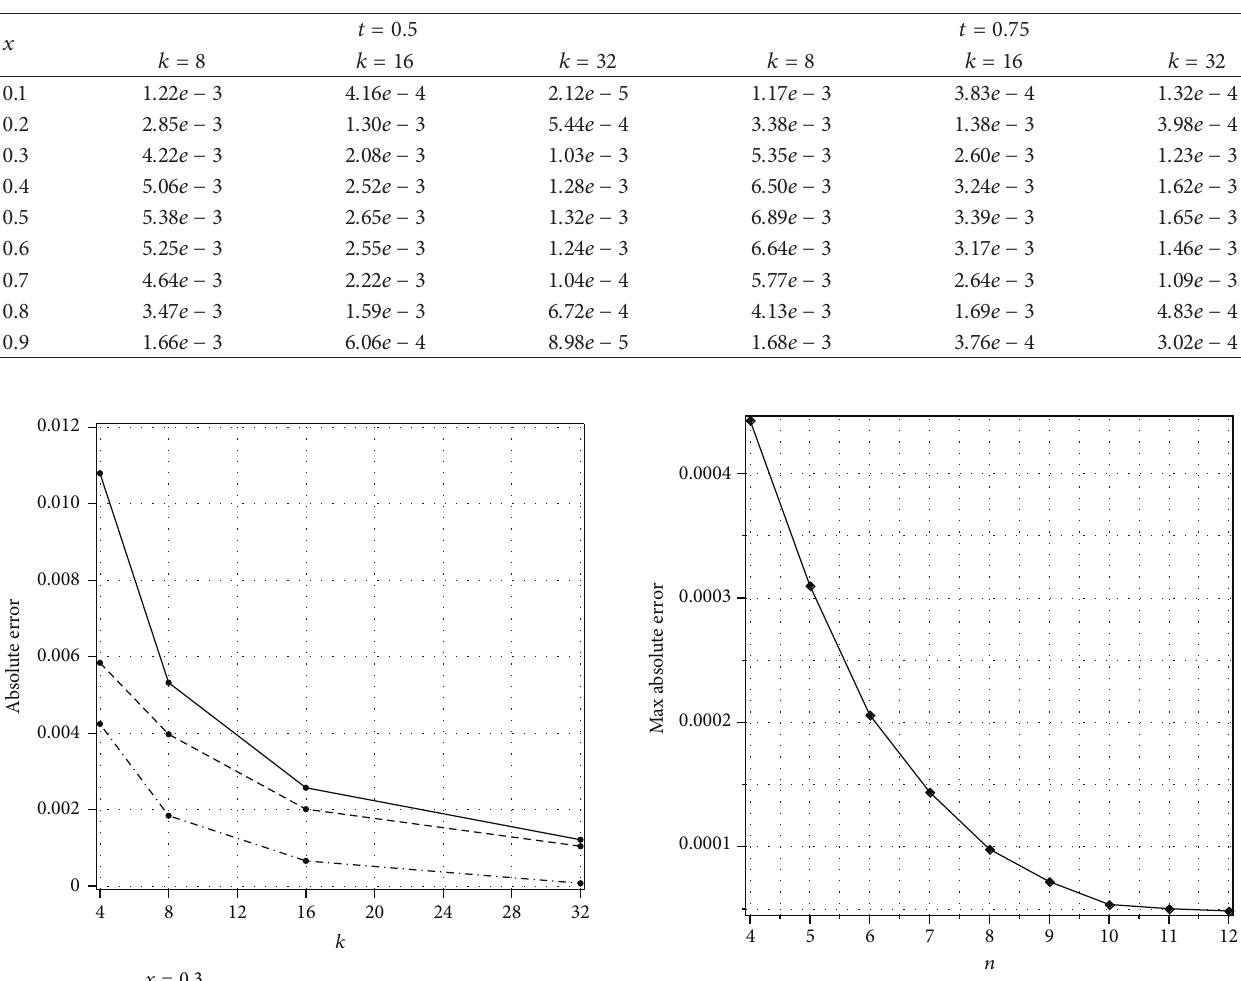
Table 2: The values of absolute error with 𝑛 = 3 and 𝑘 = 8,16, 32 for Example 2.